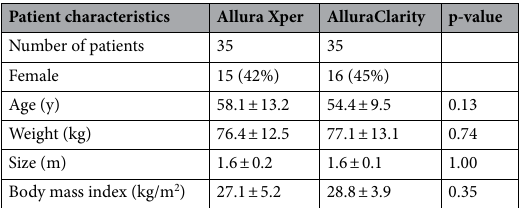
Table 1. Patient demographics. Data presented as mean ± standard deviation; * =